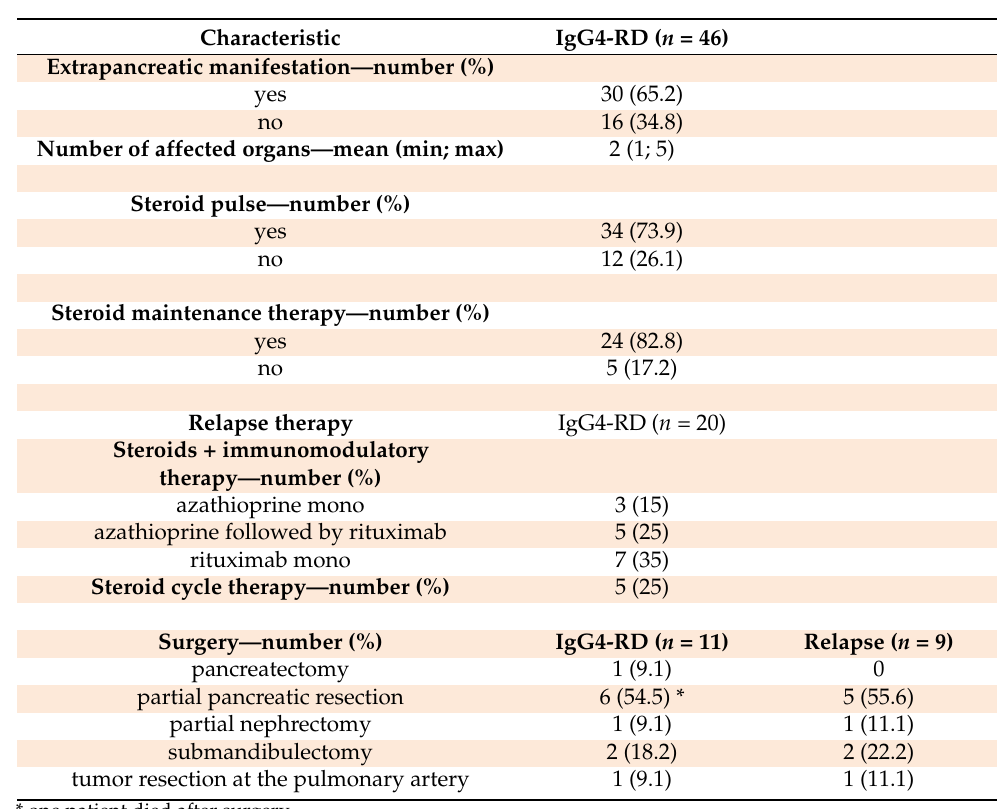
Table 2. Clinical and therapeutic aspects of patients with IgG4-related